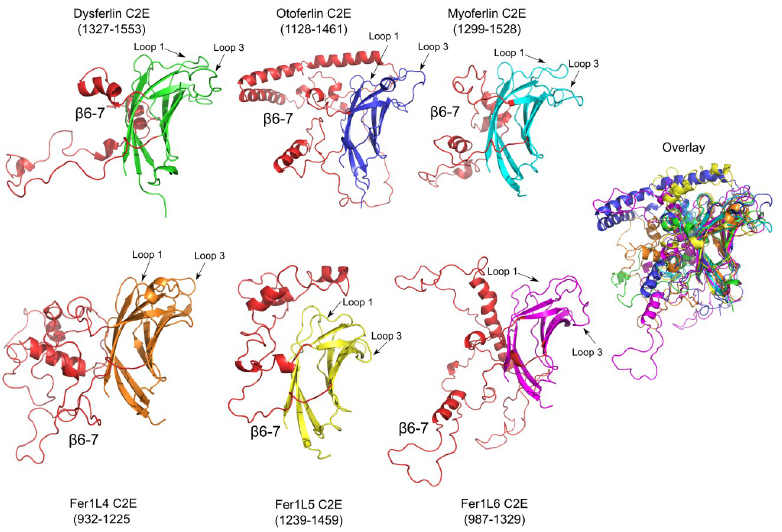
Fig 10. C2E models for dysferlin C2E (green), otoferlin C2E (blue), myoferlin C2E (cyan), Fer1L3 C2E (orange), Fer1L5 C2E (yellow), Fer1L6 C2E (magenta). The β 6–7 subdomain of C2E is labeled and colored in red. The superposition of all six C2E models is labeled as